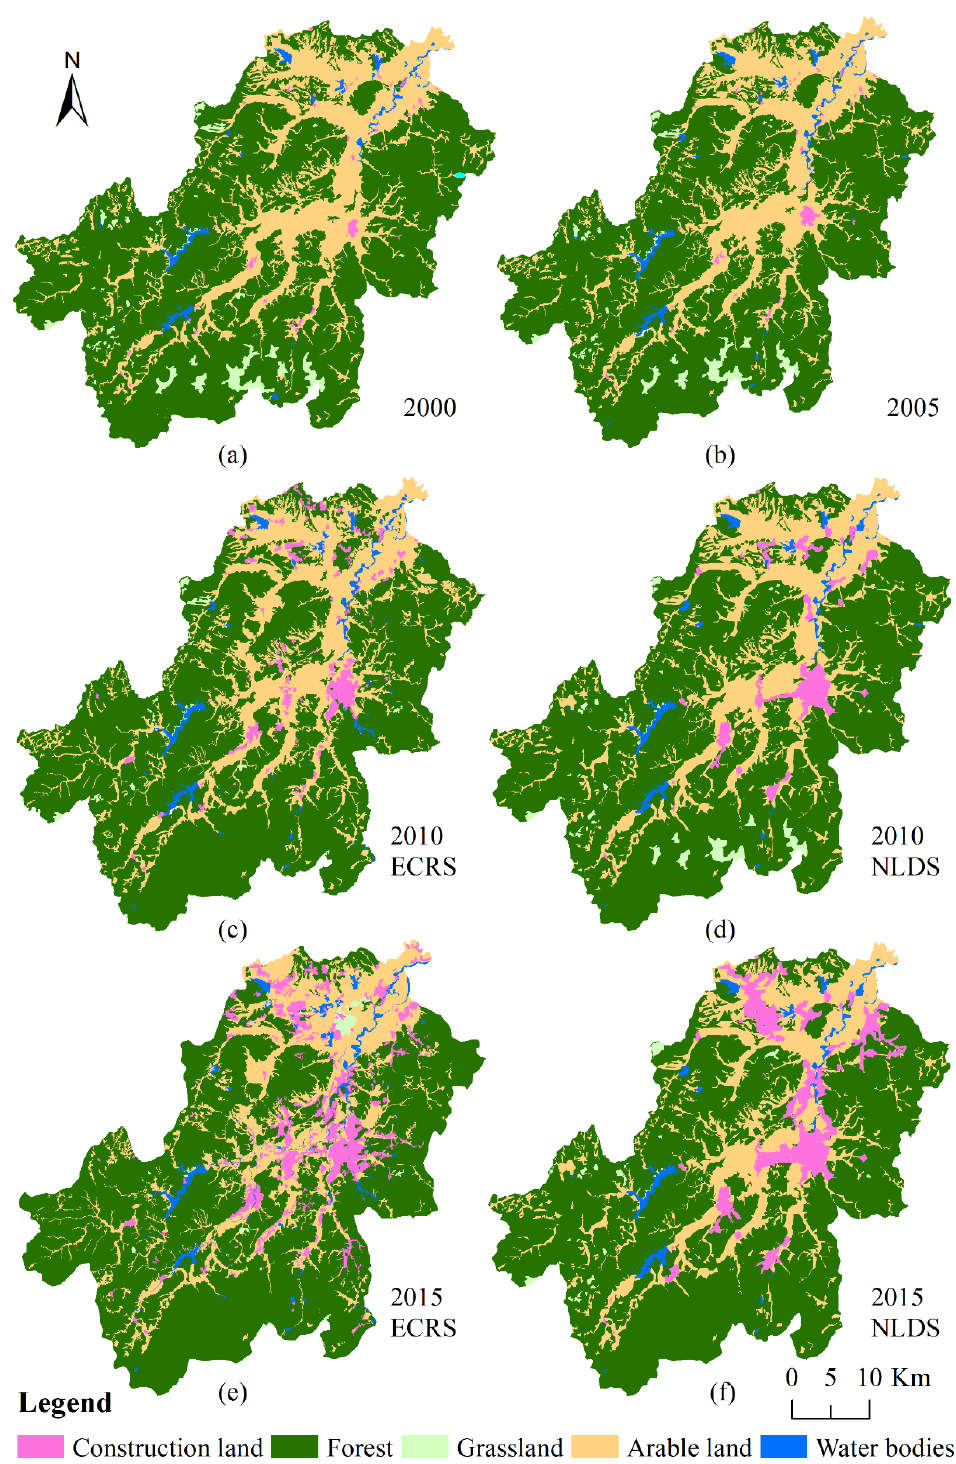
Figure 2. Land use of 2000 ( a ), 2005 ( b ), 2010 and 2015 in Anji County under an Ecological Conser- vation Redline implementation scenario (ECRS) ( c , e ) and a normal land-use development scenario (NLDS) ( d , f ).